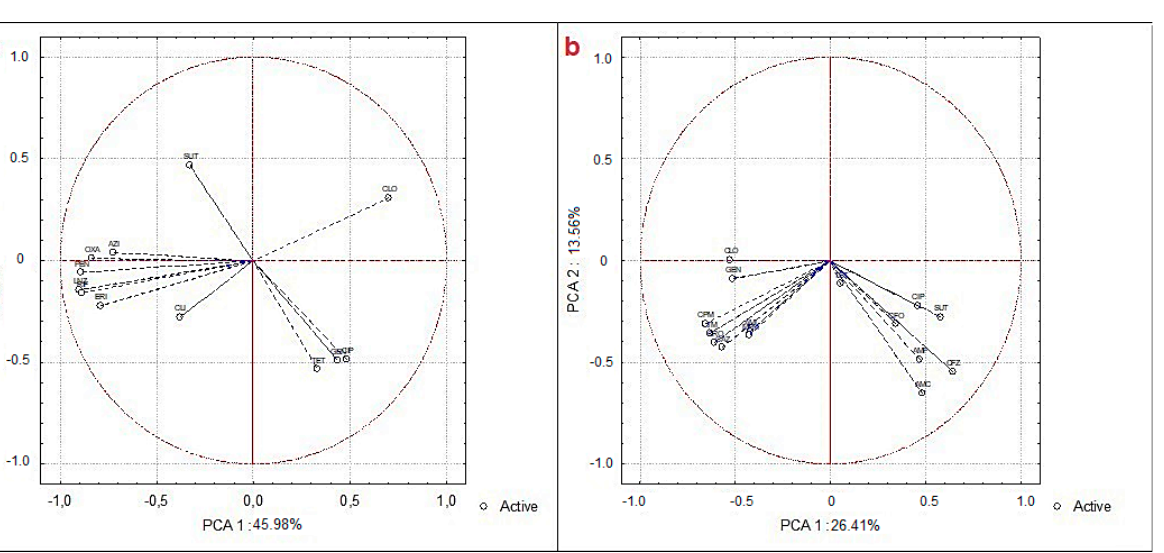
Figure 3. PCA of resistance and susceptibility data of bacterial strains isolated from water and sediment samples from Meia Ponte River. ( a ) Dot and vector plot of Gram-positive rod/bacillus and Staphylococcaceae data. ( b ) Dot and vector plot of Enterobacteriaceae and Pasteurellaceae data. For the Gram-positive rod/bacillus and Staphylococcaceae data, two groups with in- ter-correlations were formed—a group medially in the fourth quadrant of the PCA and another group of data influenced by the third quadrant of the PCA—both being negatively influenced by PCA1. For the multiple analyses of Enterobacteriaceae and Pasteurellaceae regarding resistance, two large groups were grouped: one negatively influenced by PCA1 and PCA2 and the other moderately positively influenced by PCA1 and negatively influ- enced by PCA2. The total variance of the data was 39.96% (Figure 3b). From the analysis of correlations performed for each two antimicrobials, only the correlation between CFZ with AMC and AMP was positively moderately strong and sta- tistically significant for the resistance of Gram-negatives. The other correlations found were reasonable and negative (Table S10). For Gram-positive bacteria (Table S11), the very strong, statistically significant correlations were found between LNZ with ERI, PEN and RIF, and between PEN and OXA. The correlations and inter-correlations found may be related to antibiotic classes. The correlations between lincosamides and β -lactams may be related to the mechanism of ac- tion of both, and they may act on cell wall synthesis. Another point to be discussed is that many ARGs are often found in the same plasmid or in mobile genetic elements, increasing the associations between antibiotic resistance and susceptibility [71]. The presence of several ARGs was identified in the water and sediment samples from the Meia Ponte River (Table 4). The most prevalent ARGs in the water and sediment sam- ples were e sul2 e ermC , with 100% (16/16), and sul1 , qnrB and aac(‘6)-ib with 93.75% (15/16). All genes for the eight classes of antibiotics tested were amplified. The sampling points with the highest prevalence of ARGs were point MP03, a water sample collected during the rainy season, and points MP02 and MP03, sediment samples collected during the dry season, with 83.33% (20/24). The total prevalence of ARGs in the sediment and water samples of the Meia Ponte River was 68.49% (263/384), of which 39.58% (152/384) were isolated in the rainy season and 28.91% (111/384) in the dry season. On the other hand, 29.17% (112/384) were isolated from water samples and 39.32% (151/384) from sed- iment samples (Table S12). The presence of ARGs is reported in the southeast and south of Brazil; however, in the midwest, there are very few studies [72], highlighting the importance of this study, as